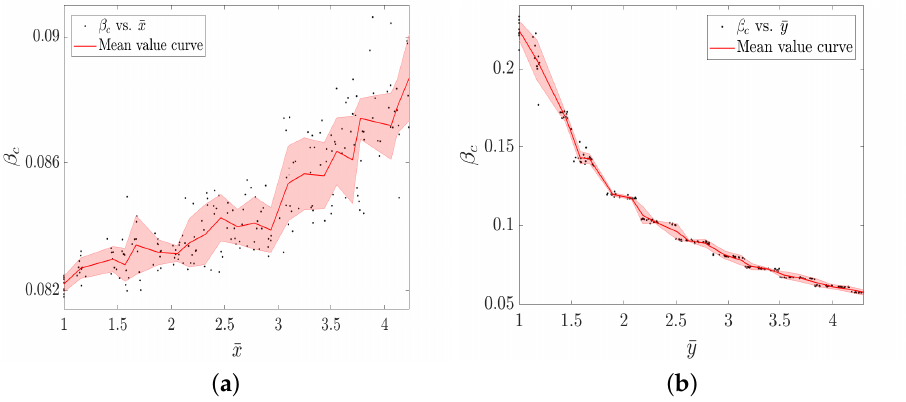
Figure 7. The epidemic spreading threshold β c as functions of ¯ x ( a ) and ¯ y ( b ), respectively. Other parameters are: γ = 0.1, µ = η = λ 1 = 0.9, , λ 2 = τ = 0.5, ι = 1.1, and ¯ y = 3 ( ¯ x = 3 ) when studying how the ¯ x ( ¯ y ) works on the β c